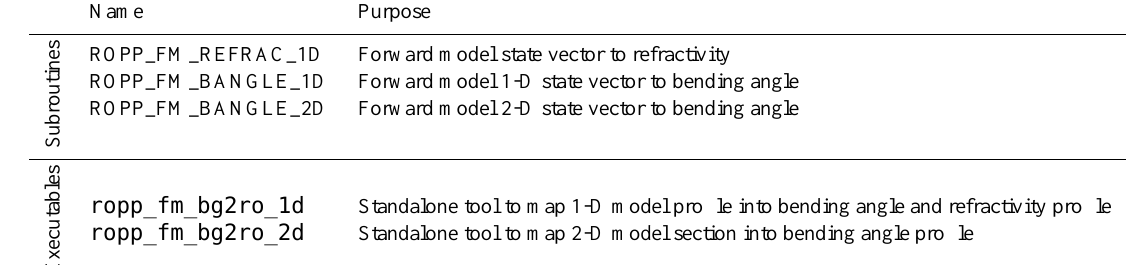
Table 5. Subroutines and standalone executables in the ROPP FM module.